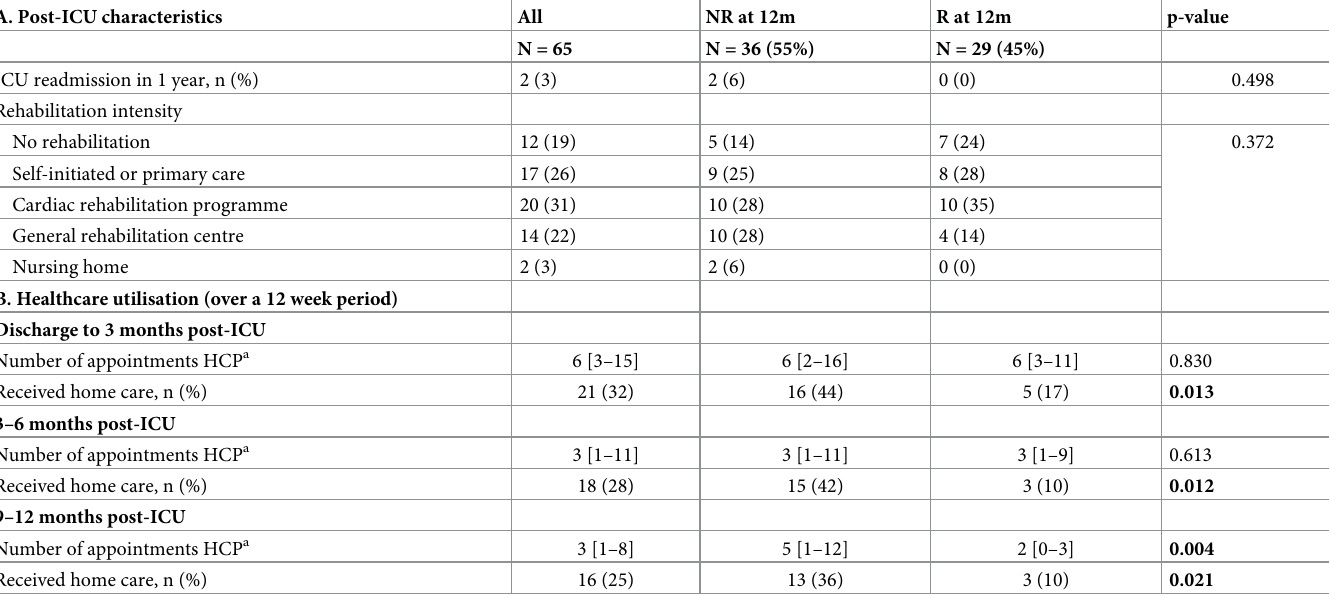
Table 2. Post-ICU characteristics (A) and healthcare utilisation (B) over the first year after ICU